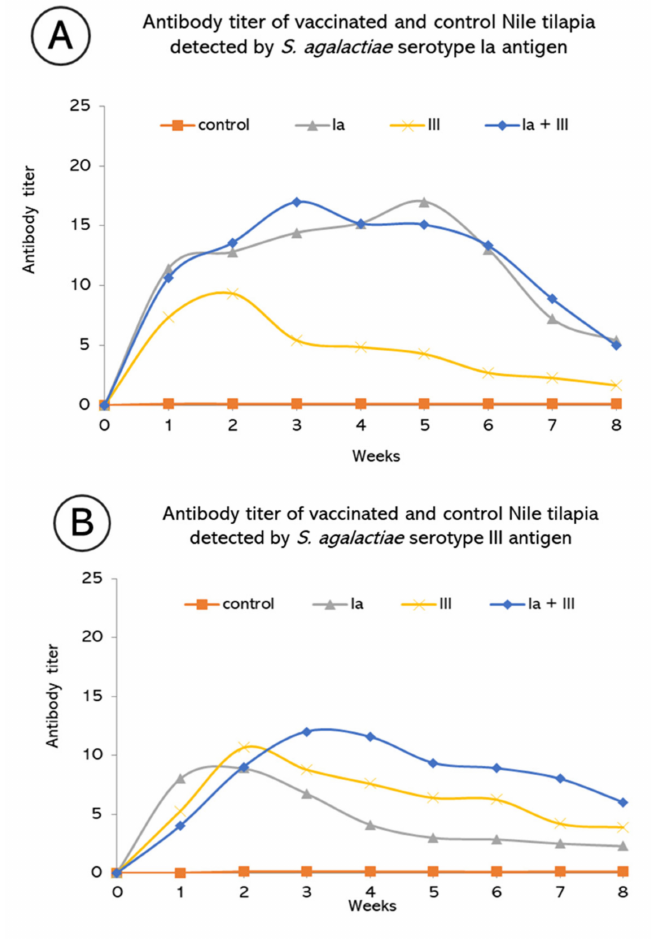
Figure 3. Antibody titer of Nile tilapia ( Oreochromis niloticus Linn.) immunized with formalin- inactivated vaccine of S. agalactiae serotype Ia and III. Titer was detected with two different antigens ( A ) serotype Ia ( B ) serotype III. Data were reported as mean ± SD ( n =